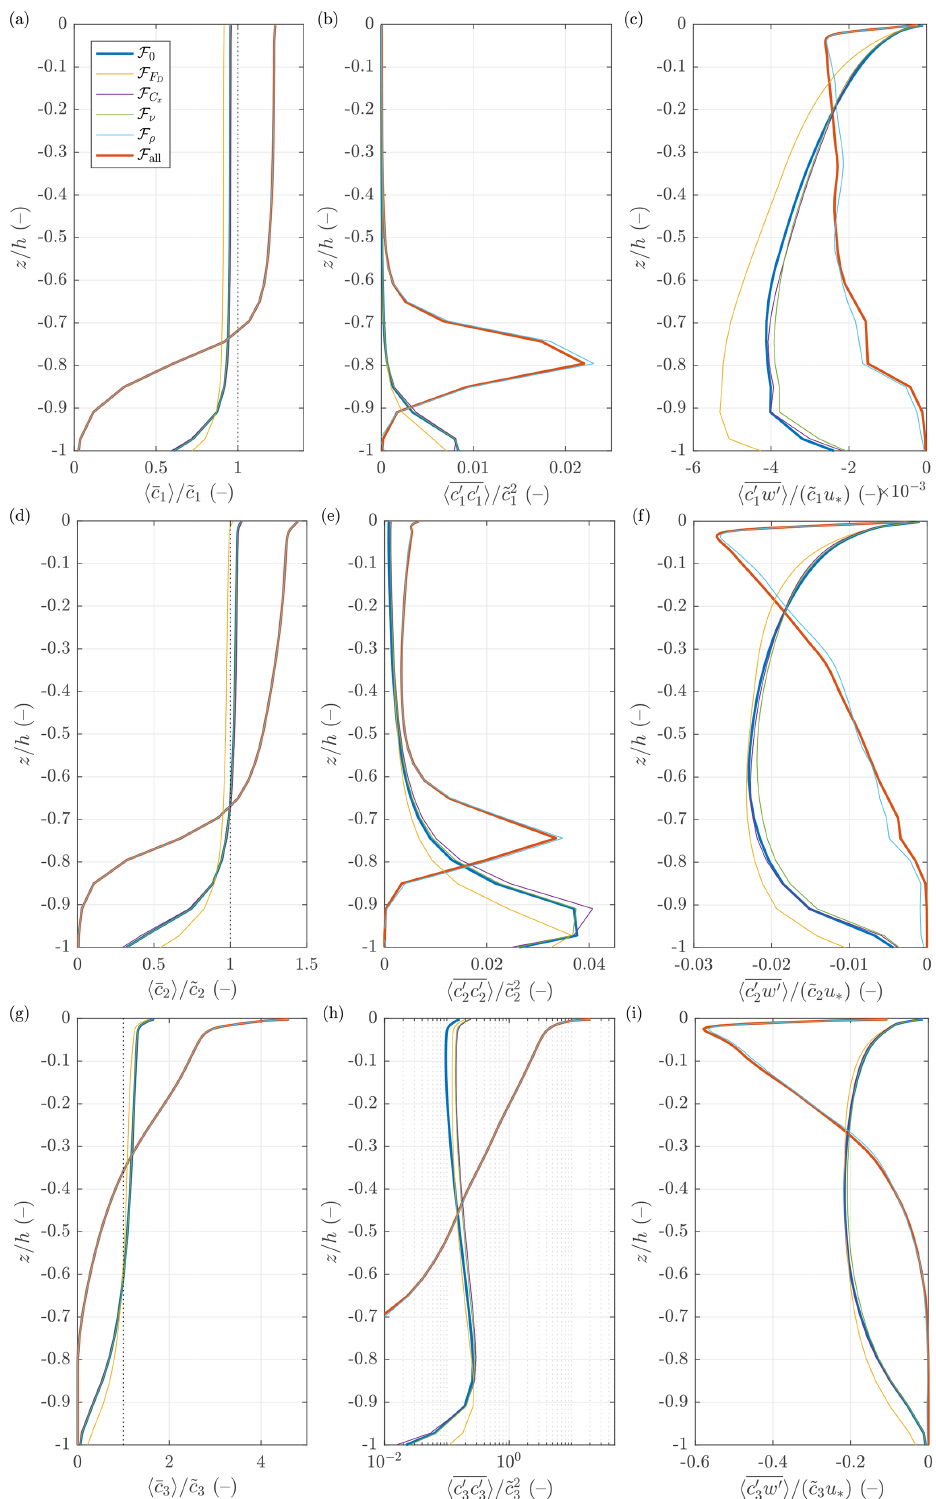
Figure 10. Vertical profiles of the mean (a, d, g) , variance (b, e, h) , and vertical flux (c, f, i) of the frazil volume fraction for size classes 1–3 for U a = 30ms − 1 and T a = − 20 ◦ C for all six simulation series. Note the different x -axis ranges in the plots; in (h) , the x axis is